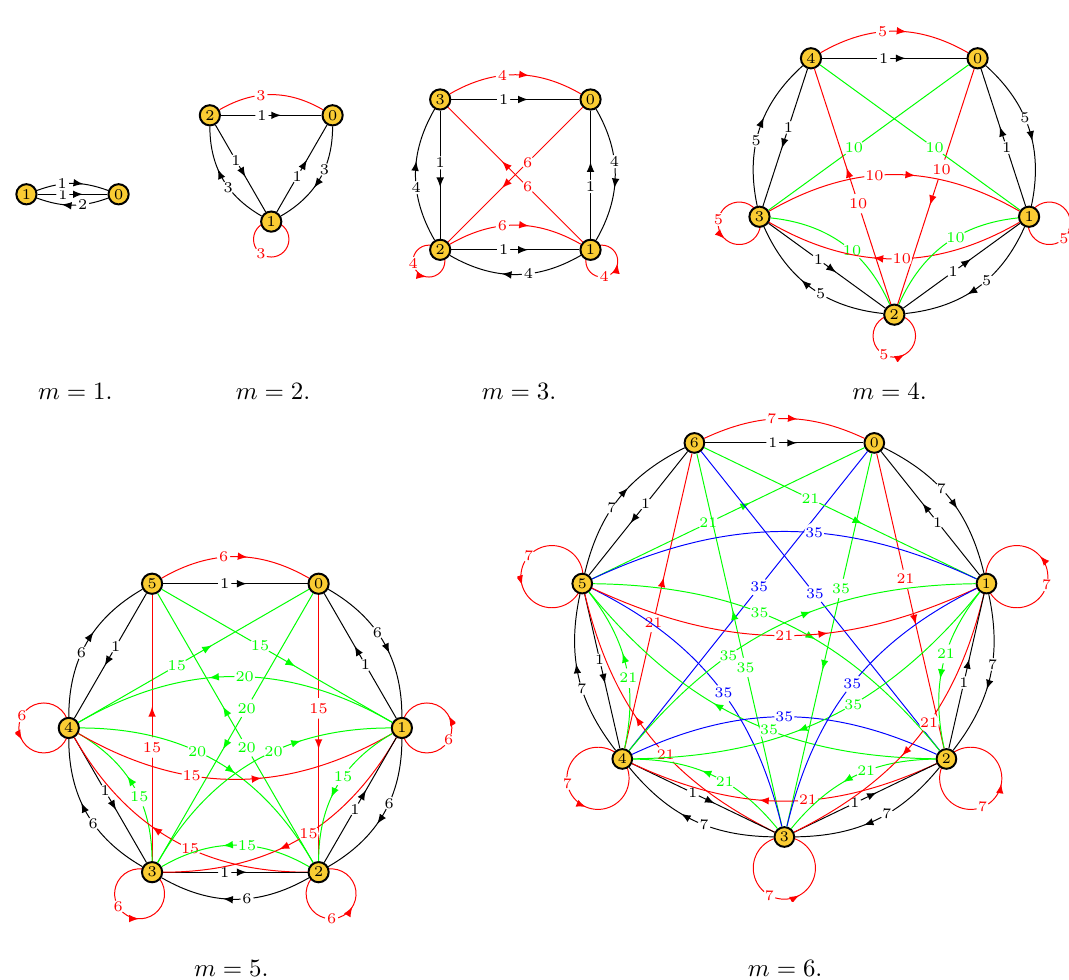
m = 6. m 6. Black, red, green and blue arrows represent (cid:20) (cid:20)